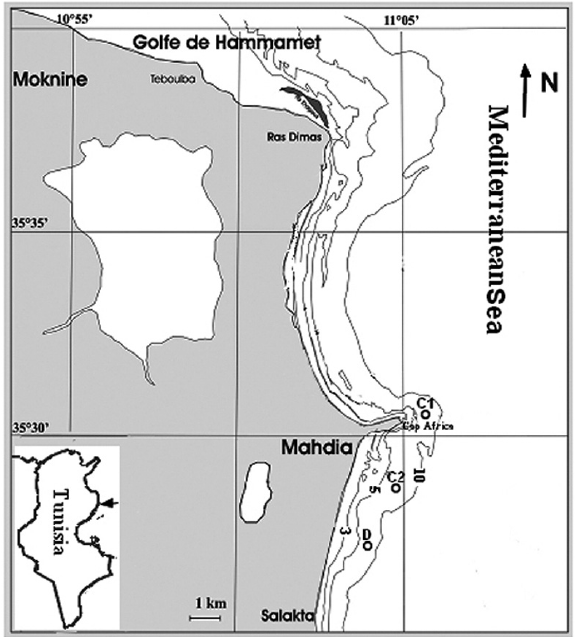
Fig.1. Map of the study area, showing the sampling stations: C1 and C2, control stations; D, disturbed